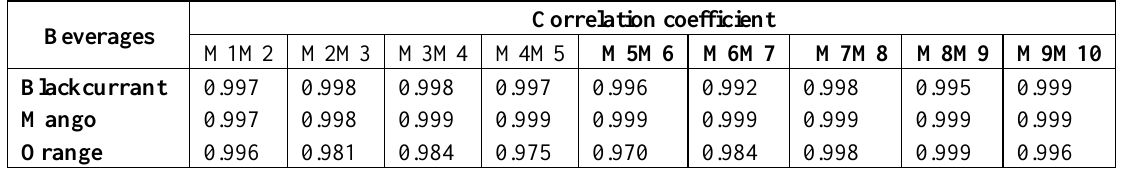
Table 2. The r values obtained for 10 measurements of blackcurrant, mango and orange juices.